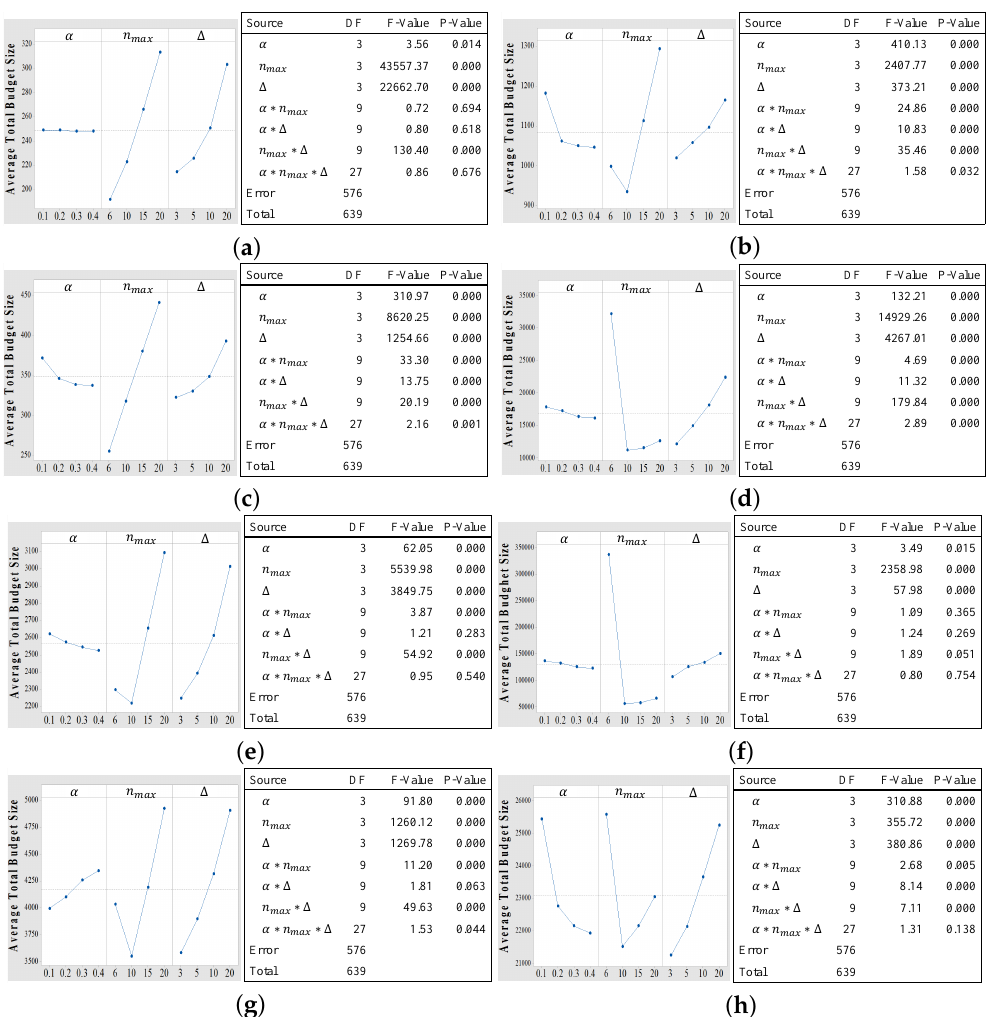
Figure A2. The main effect plots and the ANOVA tables on different multimodal optimization benchmark functions. ( a ) F1: One-dimensional equal optima. ( b ) F2: Himmelblau’s function. ( c ) F3: Six-hump camel back. ( d ) F4(2D): Shubert function. ( e ) F6 ( 3,4 ) : Modified Rastrigin function. ( f ) F6 ( 2, ··· ,2 ) : Modified Rastrigin function. ( g ) F7(1-2D): Composition function 1. ( h ) F7(2-2D): Composition function